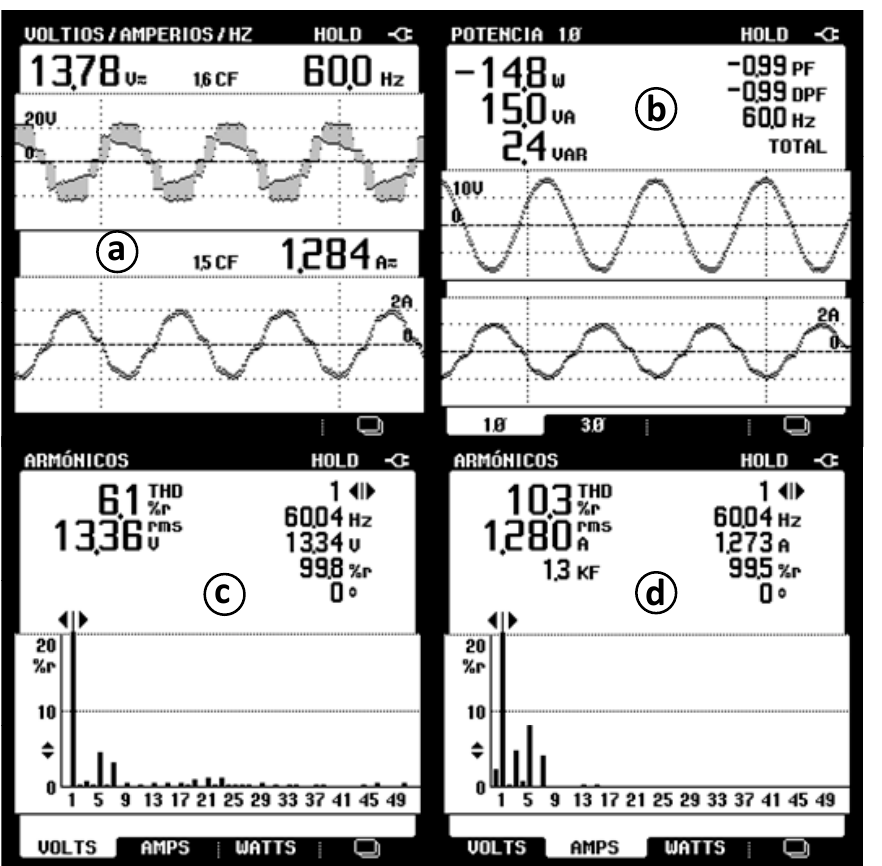
Figure 16. Fluke 43B-based power quality analysis of grid-tied SPFLC waveforms without the activation of the DC-link split capacitors’ voltage balancing. ( a ) SPFLC output voltage 𝑉 (cid:3007)(cid:3013)(cid:3004) and the resulting grid current 𝑖 (cid:3034) from the vector control technique; ( b ) grid powers, grid factors, 𝑉 (cid:3034) and 𝑖 (cid:3034) ; ( c ) spectrum of 𝑉 (cid:3007)(cid:3013)(cid:3004) ; and ( d ) spectrum of 𝑖 (cid:3034) .